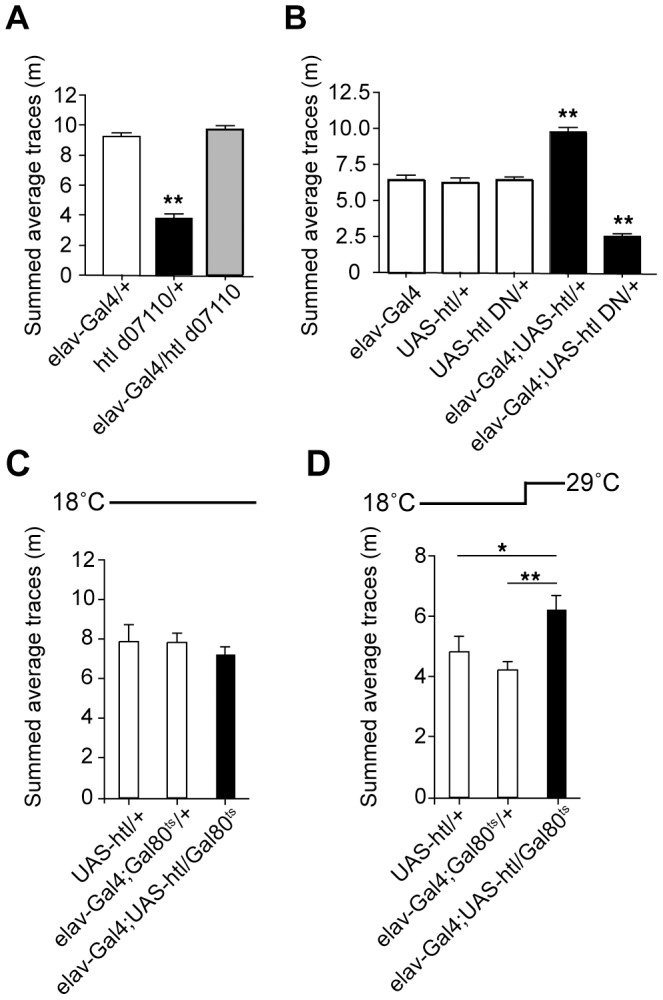

htl is required in neurons for normal ethanol-induced locomotion.(A) Neuronal-specific rescue of the behavioral phenotype of htld07110/+. Area-under-curve quantification of ethanol-induced locomotion for elav3E1-Gal4/htld07110, compared to single transgenic controls. (B) Ethanol-induced locomotion of flies overexpressing wild-type or dominant-negative Htl under the control of elavC155-Gal4, compared to single transgenic controls. (C,D) Overexpression of Htl in the adult nervous system increases ethanol-induced hyperactivity. Area-under-curve quantification of ethanol-induced locomotion for flies expressing Htl under the control of elavC155-Gal4. Expression of UAS-htl by elav-Gal4 was placed under the control of Gal80ts. (C) Flies maintained at 18°C, at which Gal80ts represses Gal4 function. (D) Flies raised at 18°C, then shifted to 29°C (at which Gal80ts is inactivated) for 48 hours before behavioral assays. *p<0.05, **p<0.01 One-way ANOVA with Neuman-Keuls post-hoc test.